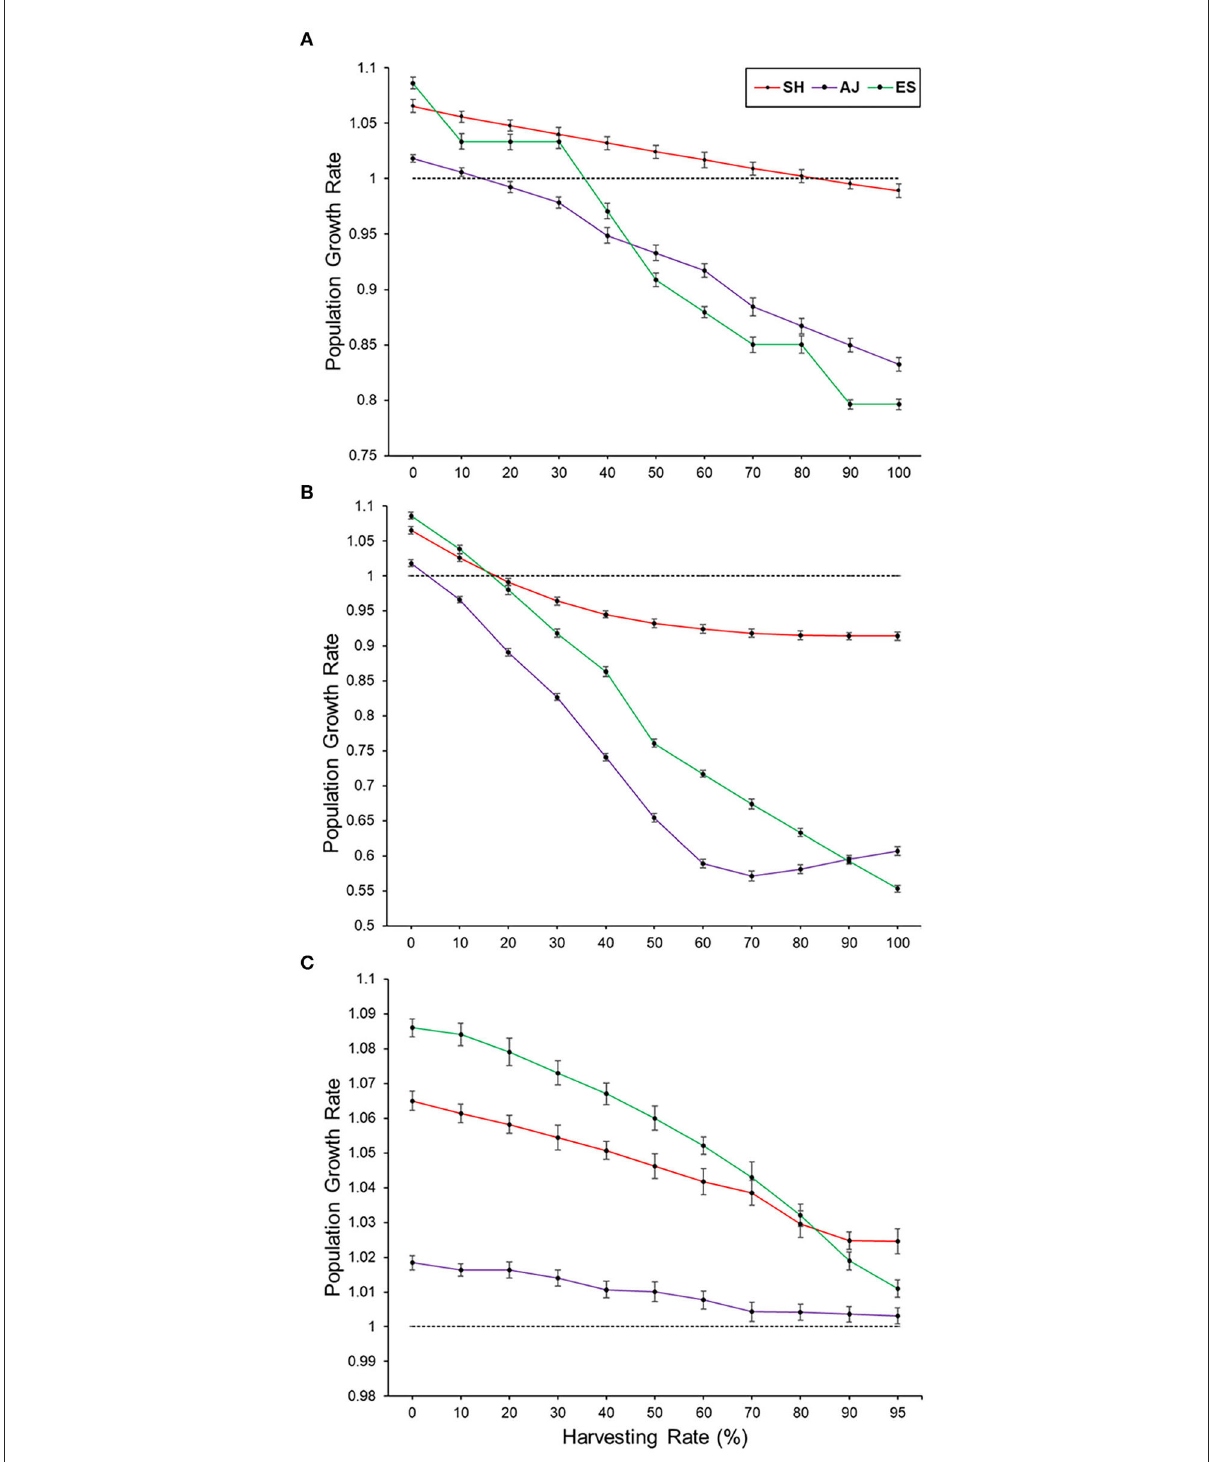
FIGURE3 Relationship between different harvesting rates and population growth rates in different harvesting scenarios for three different populations. (A) Simulations for mature individuals harvesting only (scenario 2); (B) simulations for larger individuals (DGL > 65mm; scenario 3); (C) simulations for fruit harvesting (scenario 4; see the “Harvesting simulations” subsection on how to calculate fruit harvesting limits). The dashed horizontal black line in axis y = 1 represents the threshold at which harvesting is sustainable ( λ ≥ 1) or unsustainable ( λ <